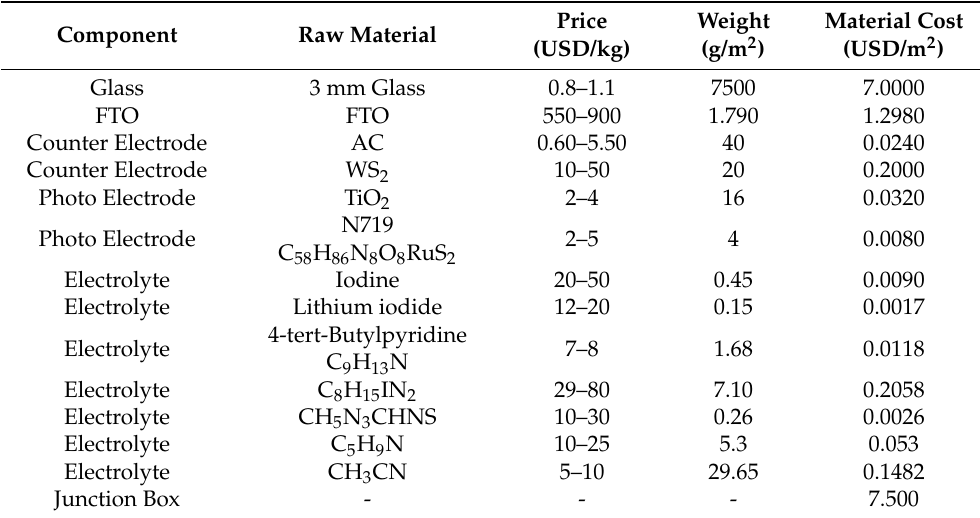
Table 1. Materials costs for the reference module.